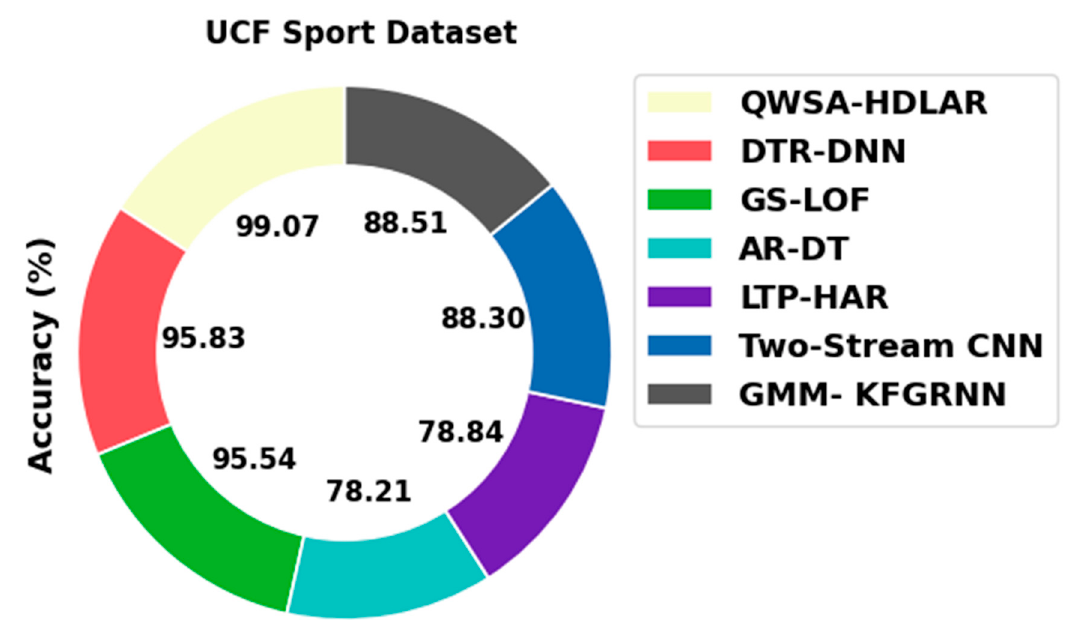
Figure 9. Comparative 𝑎𝑐𝑐𝑢 (cid:3052) analysis of QWSA-HDLAR model on UCF Sport dataset.